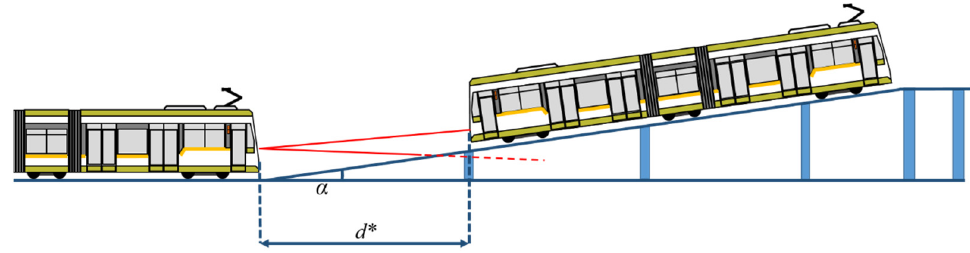
Figure 5. Uphill slope LiDAR measurement.